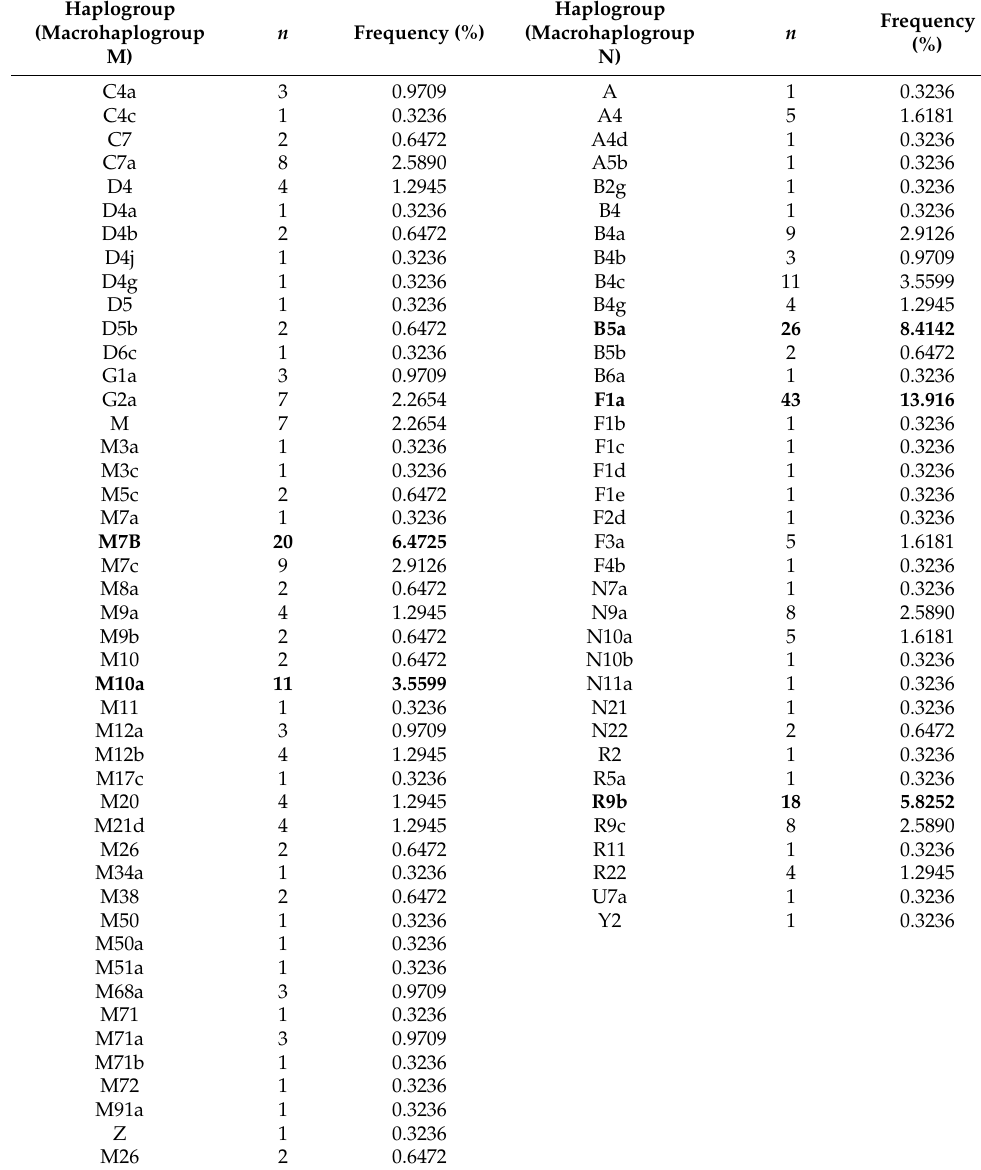
Table 2. Pairwise F ST among regional Thai populations. Region North North Northeast South - Lower left half pairwise F ST . Bold text indicates F ST p -value. All 264 haplotypes were subsequently classified into 82 haplogroups using Haplo- Grep2 with PhyloTree 17 and EMPOP [54]. The most frequent haplogroups were: F1a (13.92%, n = 43); B5a (8.41%, n = 26); M7b (6.47%, n = 20); R9b (5.83%, n = 18); and B4c (3.56%, n = 11) (Table 3, Figure 2). Table 3. Haplogroup frequencies in Thailand (based on classification of HVI and HVII sequence data) ( n =